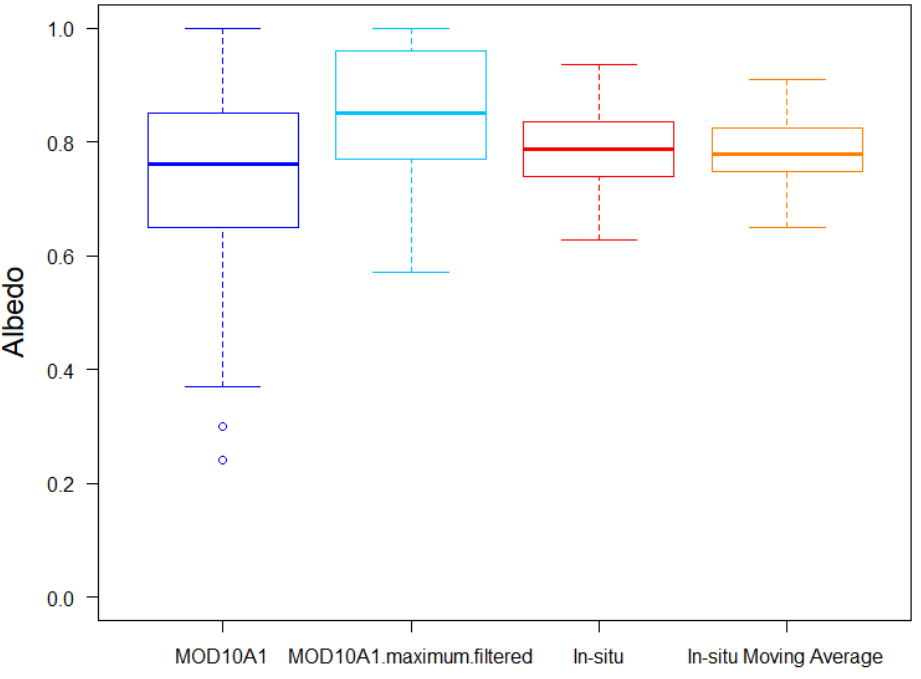
Figure 7. Boxplot of the original MOD10A1 albedo data (dark blue box), MOD10A1 albedo data filtered with the maximum filter (light blue box), original in-situ albedo (red box), and in-situ albedo filtered with a 5-day window moving average (orange box). Circles represent outliers.